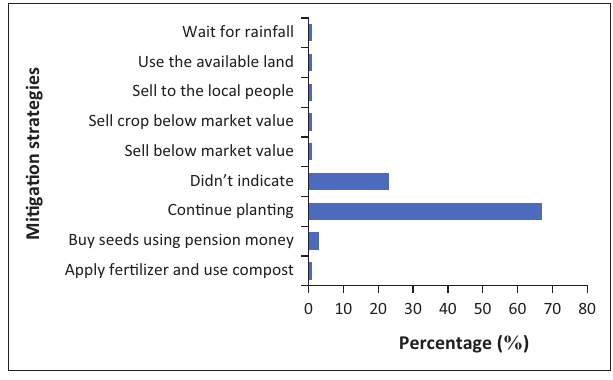
FIGURE 4: Strategies to mitigate the effects of climate risks in Thaba Chweu Local